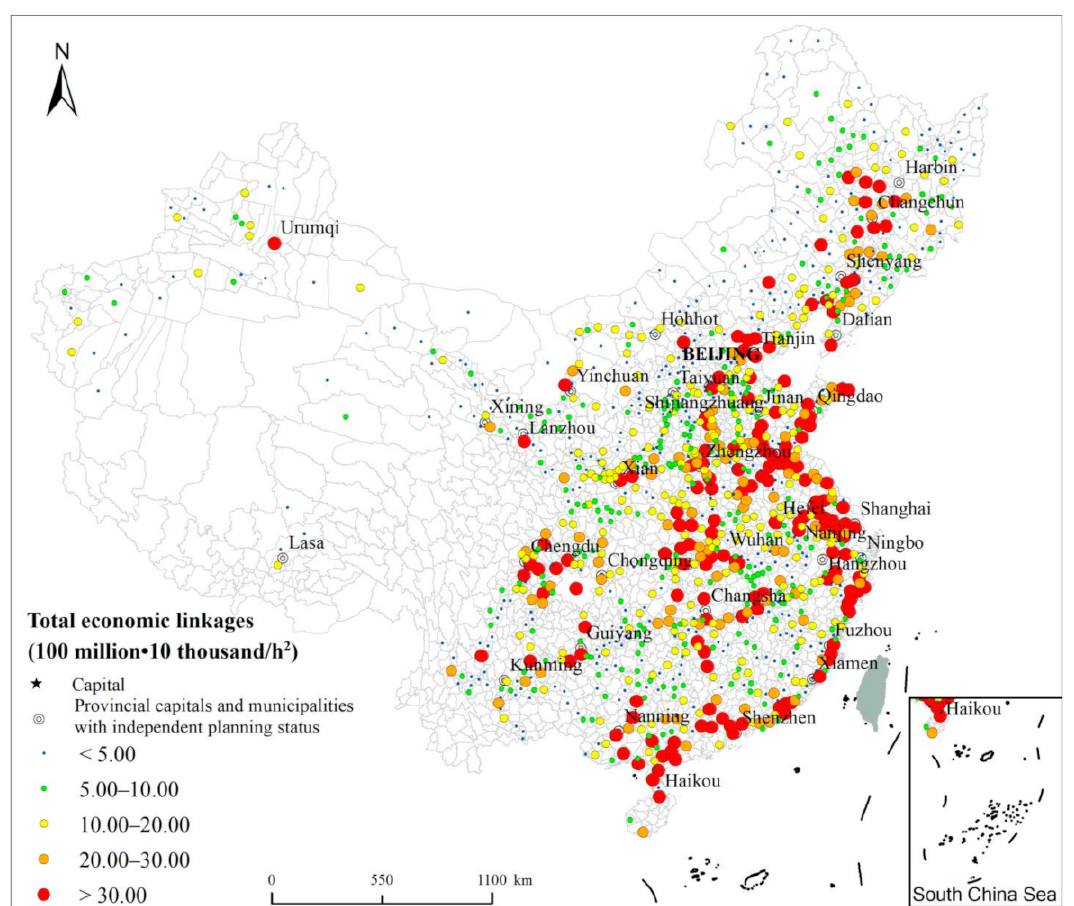
Figure 5. Spatial distribution of total economic connection in